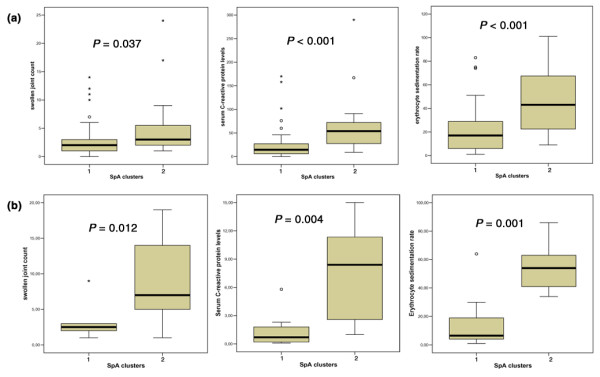
Supervised clustering analysis using the synovial histopathological parameters that were significantly associated with disease activity in spondyloarthropathy (SpA) (lining-layer hyperplasia, inflammatory infiltration, polymorphonuclear cells, sublining CD68, and sublining CD163). (a) Analysis in the cohort of 82 patients originally used to identify the histopathological parameters identified a cluster (cluster 2, n = 20 samples) which was characterized by significantly higher swollen joint count, serum C-reactive protein concentrations (mg/L), and erythrocyte sedimentation rate (mm/hour). (b)A similar analysis in an independent cohort of 17 patients confirmed these results by identifying a cluster of 7 patients (cluster 2) that was similarly characterized by significantly higher swollen joint count, serum C-reactive protein concentrations (mg/L), and erythrocyte sedimentation rate (mm/hour). Data are represented as box–whisker plots, with median, 25th to 75th percentile, and 5th to 95th percentile. Comparisons were performed with the Mann–Whitney U test.